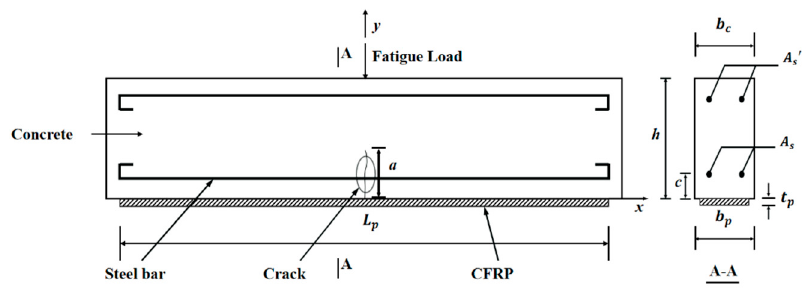
Figure 2. CFRP-strengthened RC beam with mid-span crack.